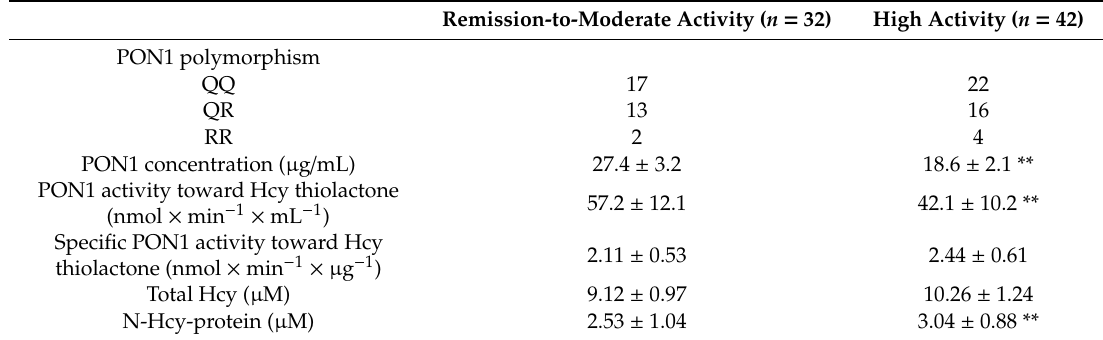
Table 3. PON1 status, Hcy, and N-Hcy protein in RA patients stratified according to the disease